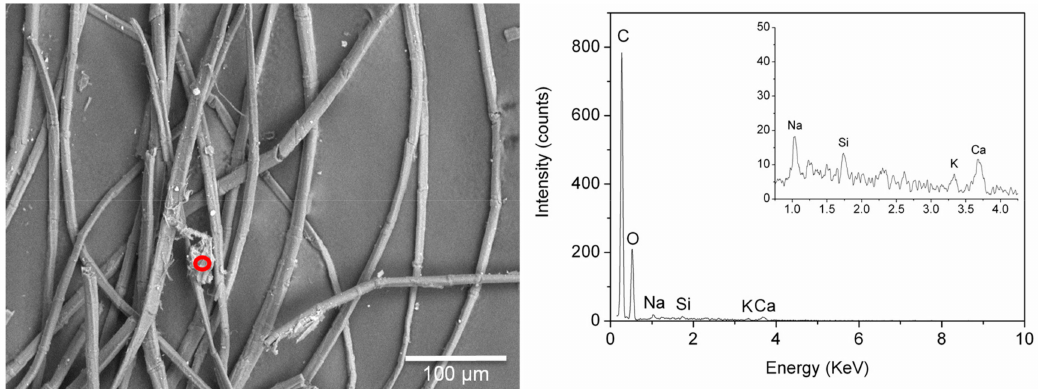
Figure 9. Back-scattered electron SEM image of sample BM3 and EDS spectrum obtain by focussing the electron beam on a coloured particle circled in red. Signals from the inorganic components are highlighted in the